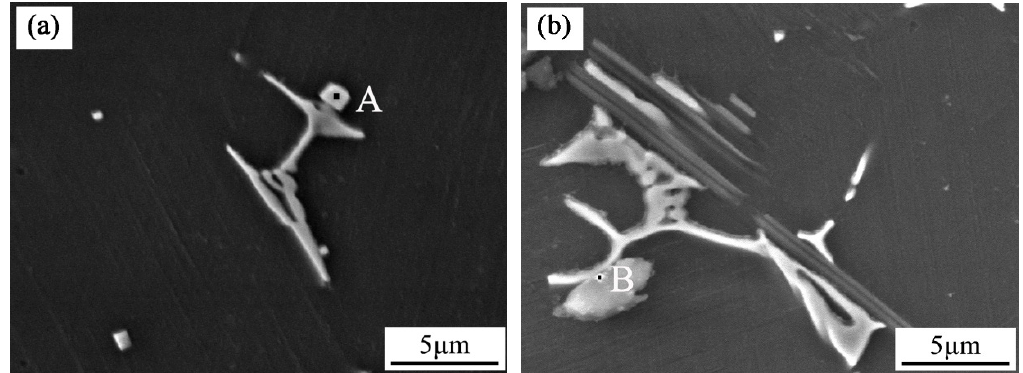
Figure 8. High magnification SEM images of Zr in the as-cast Mg-3Y-3.5Sm-2Zn-0.6Zr alloy: ( a , c ) Without UST; ( b , d ) with UST. Table 3. EDS results corresponding to the selected points in Figures 8 (wt %).